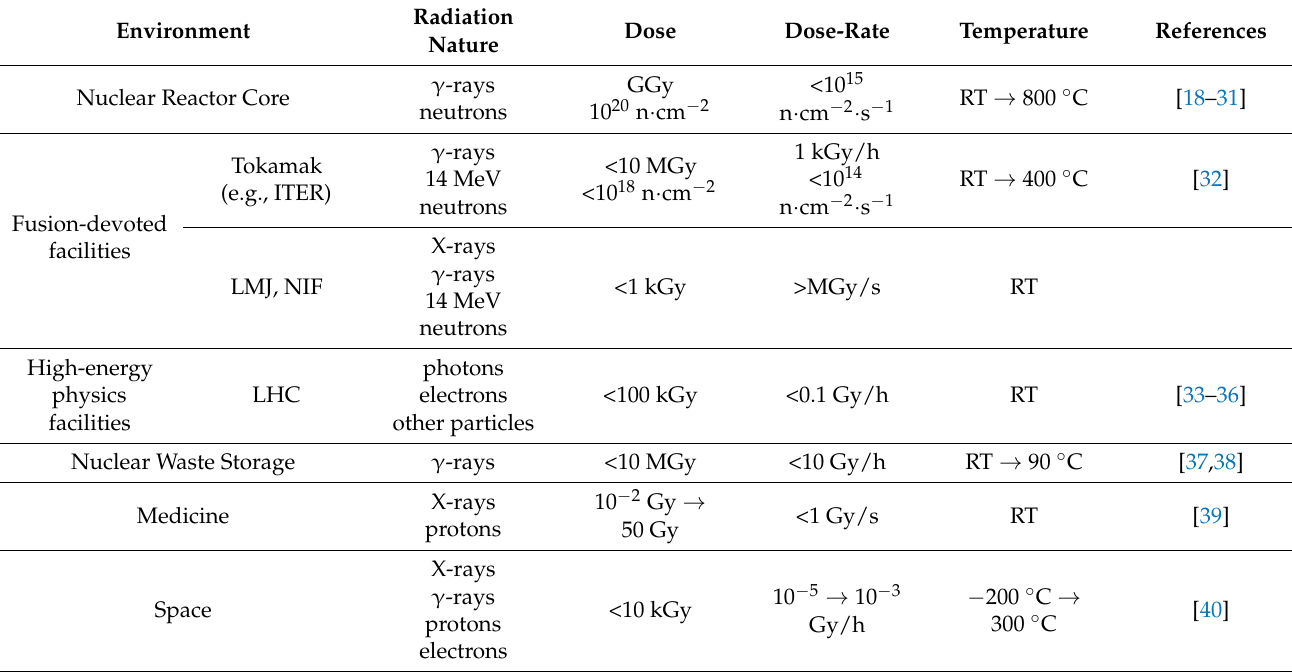
Table 1. Main characteristics of radiation environments (extracted from [14]) and list of references where the FBGs were tested in real